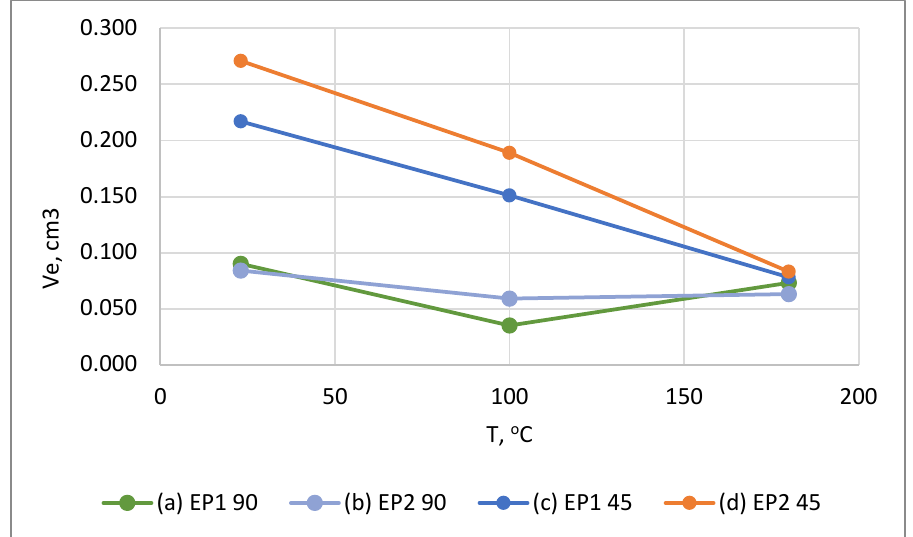
Figure 12. Dependence of wear of unfilled epoxy resin on temperature at impingement angles of 45° and 90°